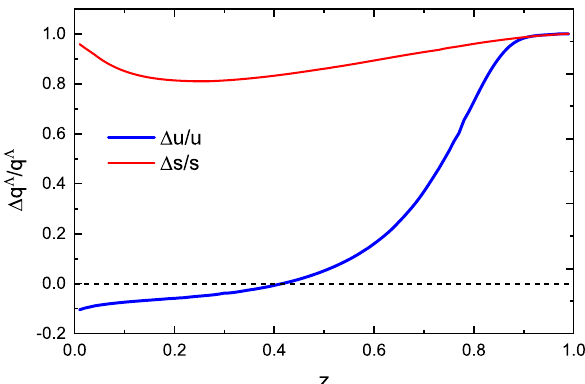
Fig. 2 The helicity distributions for valence quarks of Λ obtained by SU(6) quark–diquark model [72,73], in which distributions for u v and d v quarks are identical. The thick solid curve and the thin solid curve represent the helicity distributions of u v and s v quarks, respectively ¯ Λ = D Λ = D ¯ Λ D Λ + , we modify the fragmentation q q +¯ q q +¯ q functions obtained by the light-cone model as Ref.